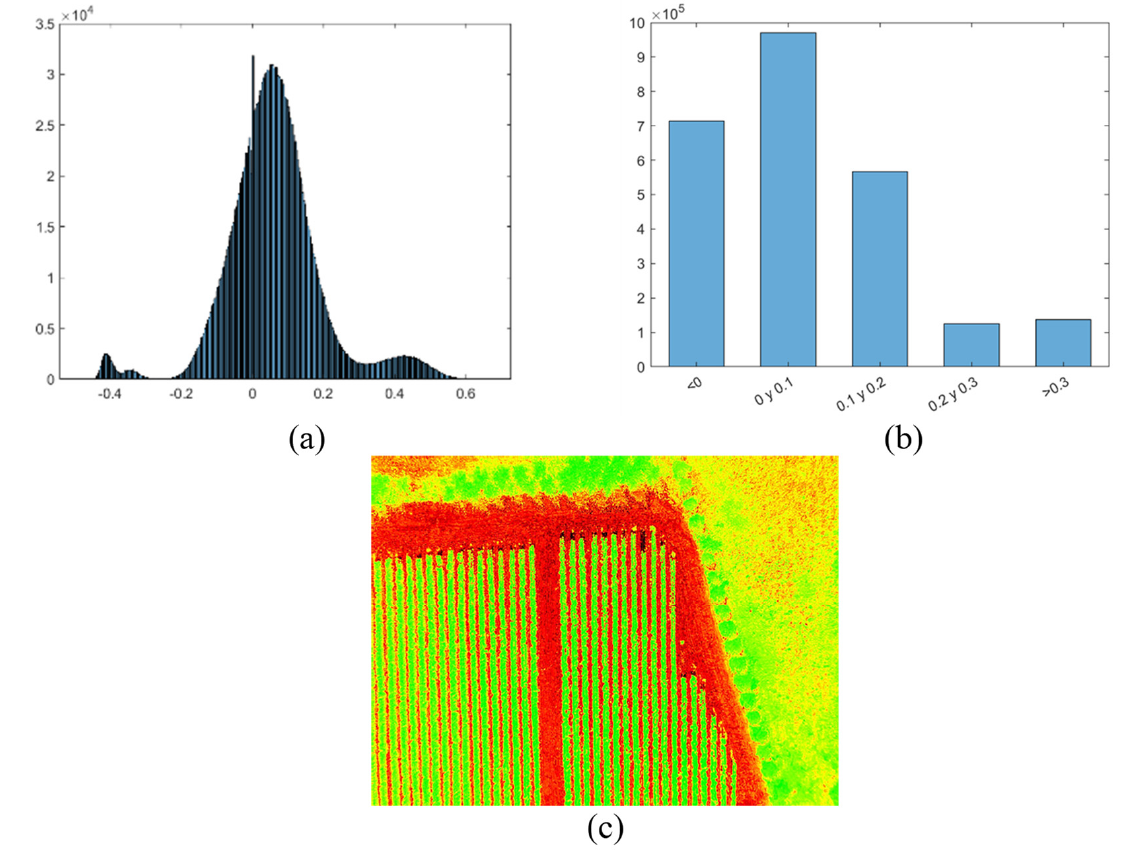
Figure 13. Snapshots of NDVI visualization: ( a ) Histogram. ( b ) Categorized histogram. ( c ) Pseudo- color image.